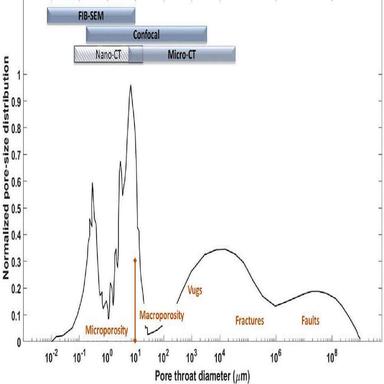
A typical example of the porethroat size distribution of a carbonate formation. The size of the pore types in carbonates: microporosity (diameter 10 μm), vugs, fractures, and event faults, is outlined on the horizontal axis. The 3D "pore-scale" characterization methods associated with carbonates are also outlined, highlighting the working range of each individual method. Confocal microscopy represents an intermediary stage between FIB-SEM and micro-CT, since nano-CT is very limited commercially.